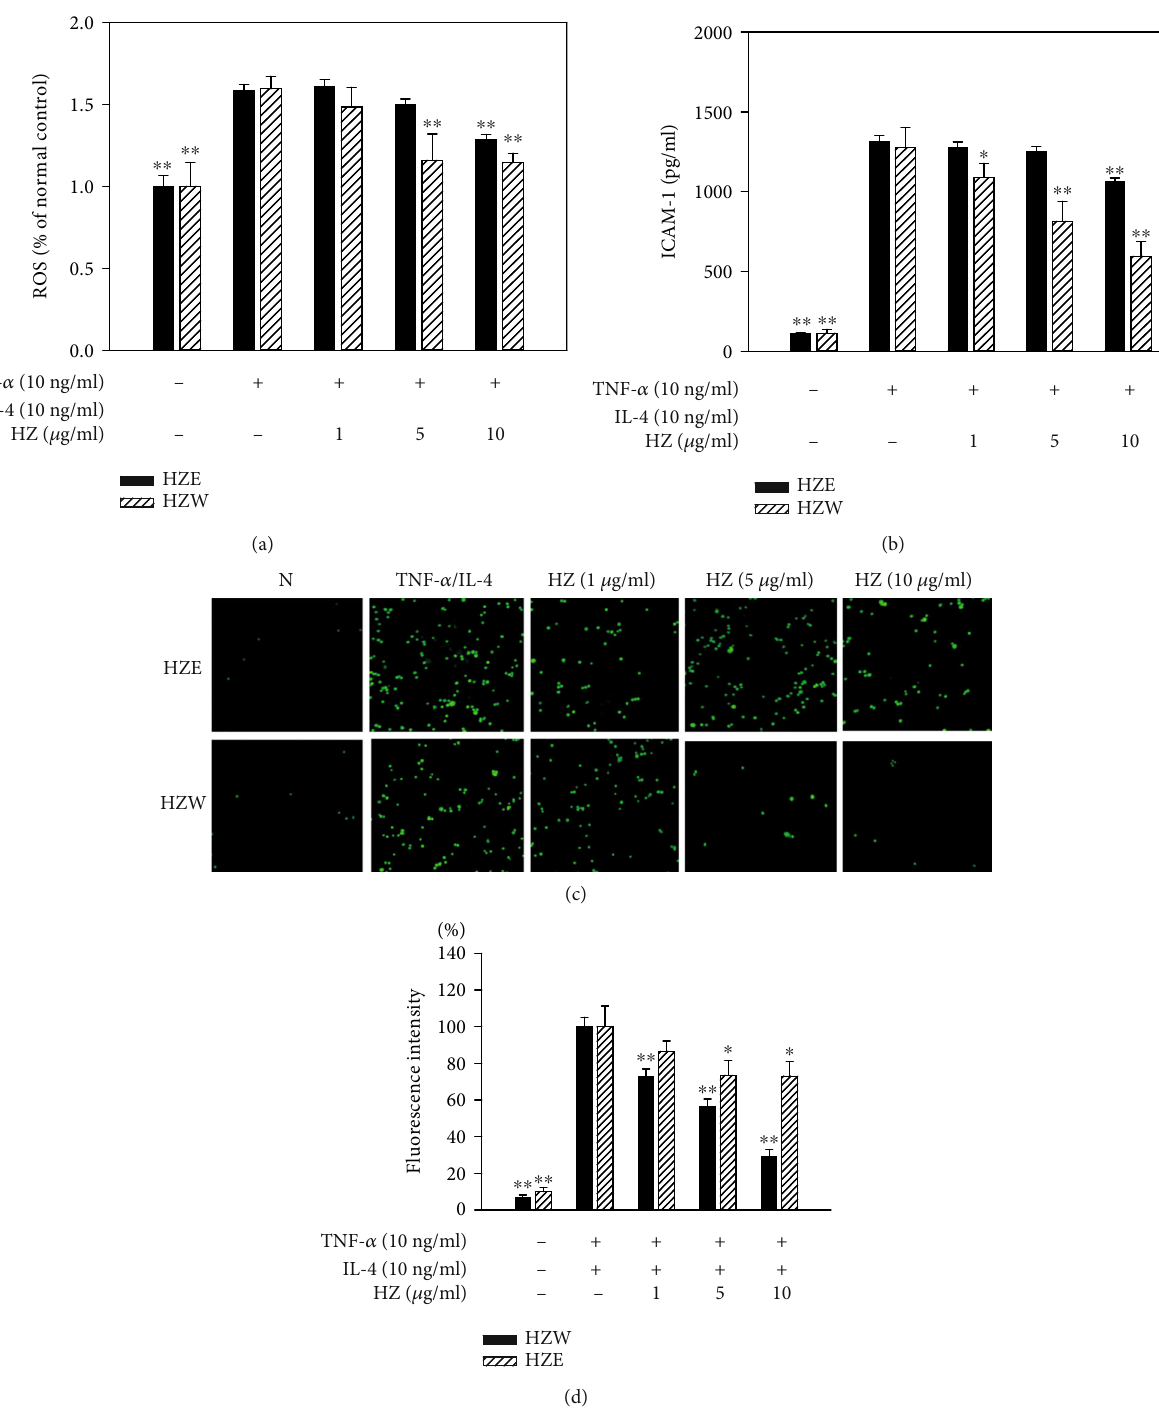
Figure 3: HZW and HZE inhibited ROS and THP-1 cell adherence to the activated BEAS-2B cells. (a) Percentage of ROS detected in cells treated with HZW or HZE compared with TNF- α /IL-4-activated BEAS-2B. (b) The levels of ICAM-1, detected by ELISA, in BEAS-2B cells activated with TNF- α /IL-4. (c) Fluorescence microscopy images of THP-1 cells labeled with calcein-AM and mixed with normal (N) and TNF- α /IL-4-activated BEAS-2B cells, in the absence or presence of HZW or HZE. HZ: Helminthostachys zeylanica . (d) Fluorescence intensity of THP-1 cell adhesion to BEAS-2B cells. The data are presented as the mean ± SEM . ∗ P < 0 : 05 and ∗∗ P < 0 : 01 compared with BEAS-2B cells stimulated with TNF- α how HZW ameliorates the e ff ects of in fl ammation, (Figure 4(d)). Prednisolone-treated OVA-sensitized mice oxidation, and the immune mechanism of asthma in the also signi fi cantly inhibited eosinophils and total cells com- animal model. pared to the OVA-sensitized mice. Hence, we only analyzed